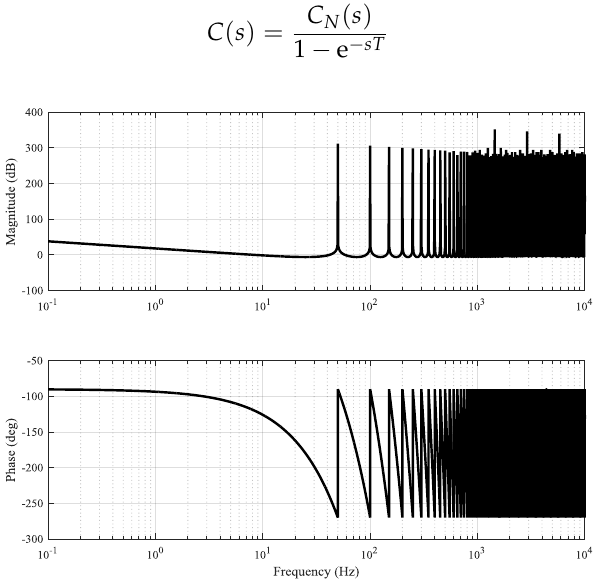
Figure 15. Repetitive controller Bode diagram.